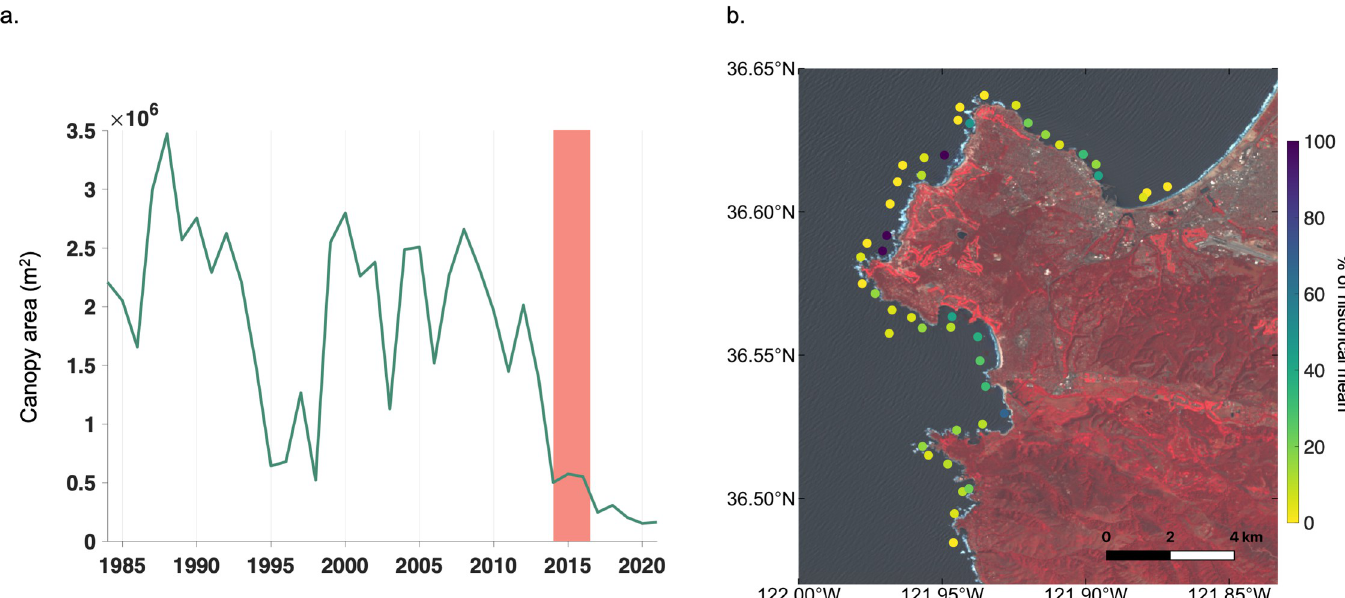
Fig 6. Kelp dynamics around the Monterey Peninsula. a.) Time series of maximum annual kelp canopy area for the Monterey Peninsula. Vertical red bar shows the timespan of the heatwave period (2014 to 2016). b.) Mean annual canopy area from 2014 to 2021 in 1 x 1 km cells as a percentage of the historical mean annual canopy area from 1984 to 2013. Values of 100% represent kelp canopy areas greater than or equal to the historical mean. Landsat imagery from